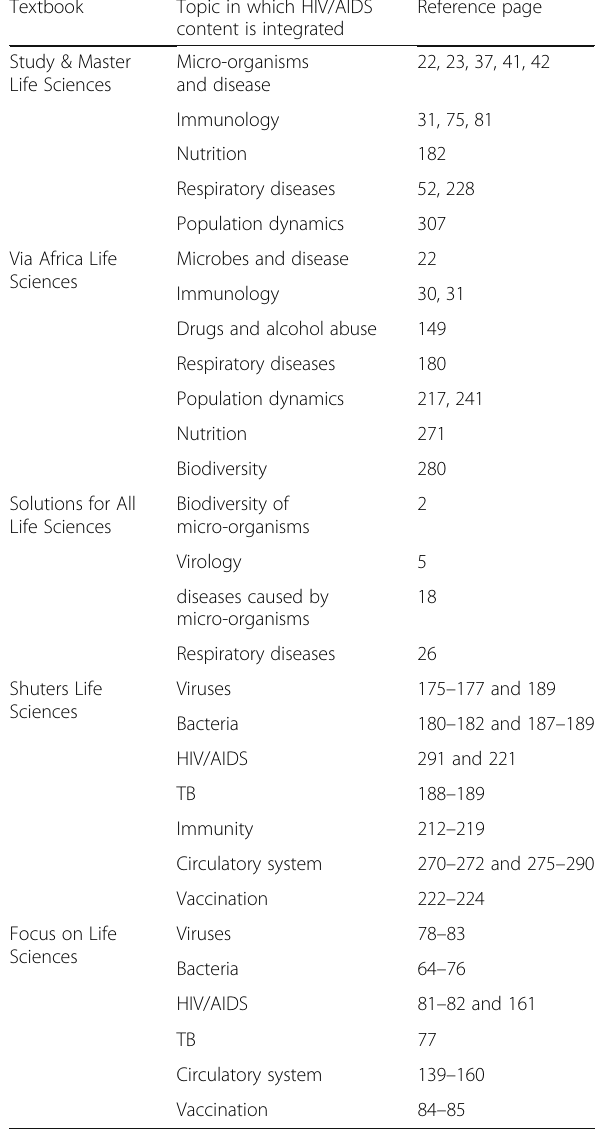
Table 1 The integration of HIV/AIDS content in different topics in the Life Sciences textbooks